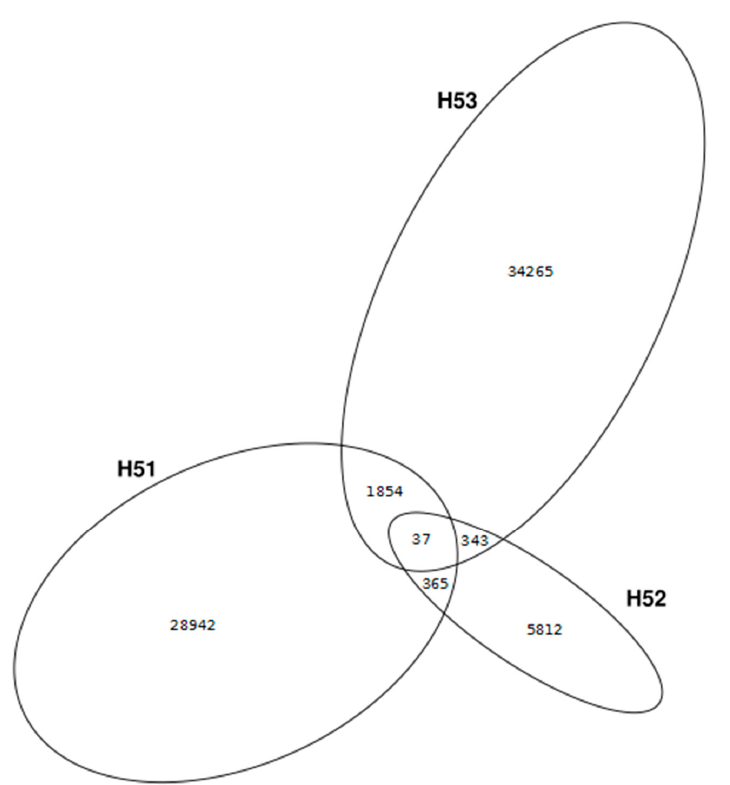
Figure 4. The venn diagram presents numbers of unique and shared viral contigs among the different viromes. Cross-assembled viral contigs (as identified by VirSorter, VirFinder and VrAP) were compared between sites by an all-versus-all clustering approach (95% identity) with CD-hit-est-2D